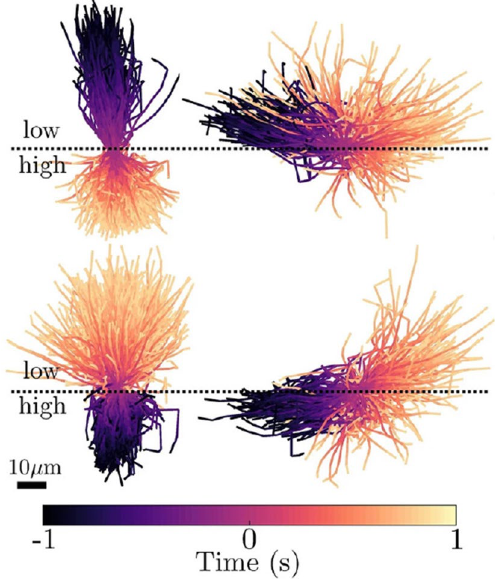
Figure 1. Trajectories of Chlamydomonas Reinhardtii going from low to high (top) and high to low (bottom) viscosities from recent experimental work 25 . The trajectories on the left are relatively steep (closely aligned to the interface-normal) while those on the right are relatively shallow and display scattering at the interface when going from low to high viscosities. Image is from the paper by Coppola and Kanstler 25 which is licensed under https:// creat iveco mmons. org/ licen ses/ by/4. 0/CC BY